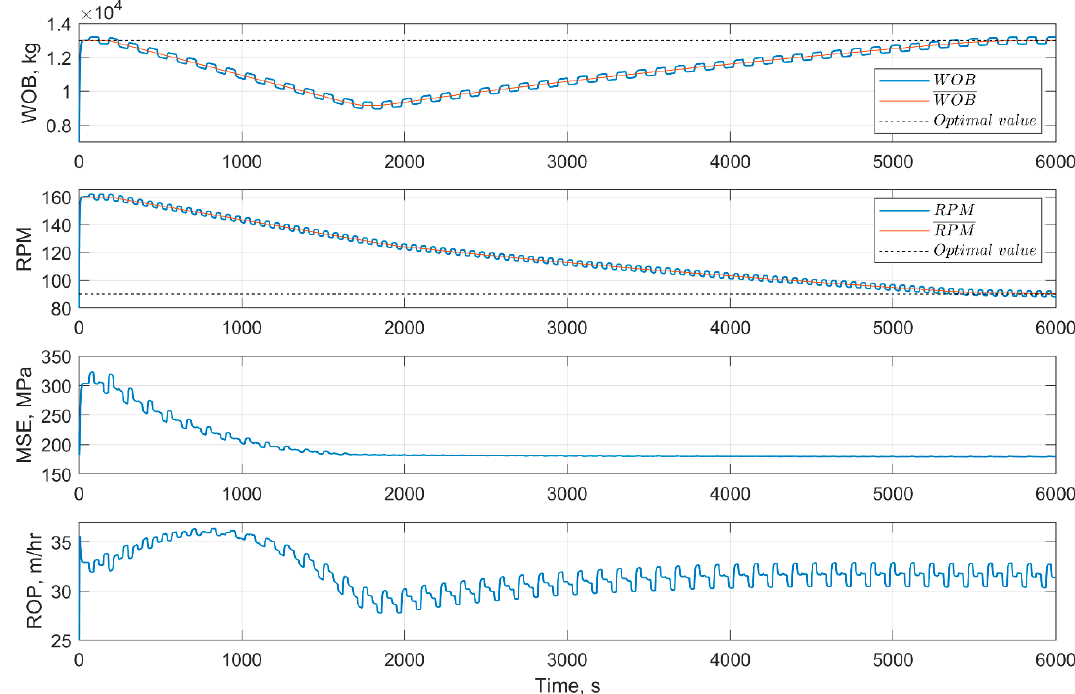
Figure 12. Simulation run 2, showing convergence for drilling initiated in the dysfunction region. Figure 13 depicts the WOB and, RPM values from Simulations 1 and 2 in the WOB - RPM plane, together with contours which mark the MSE values for drilling in Formation A . The blue and orange datapoints can be viewed as the “path” that the ES algorithm took to converge to the founder point in these two scenarios. In the case of Simulation 2, it can be seen that the path taken by the algorithm is not the most efficient way to reach the founder point. It is however close to the most efficient path to exit the dysfunction region as quickly as possible. Because of this “detour”, more time is spent to converge to the optimum in Simulation 2, compared to Simulation 1.